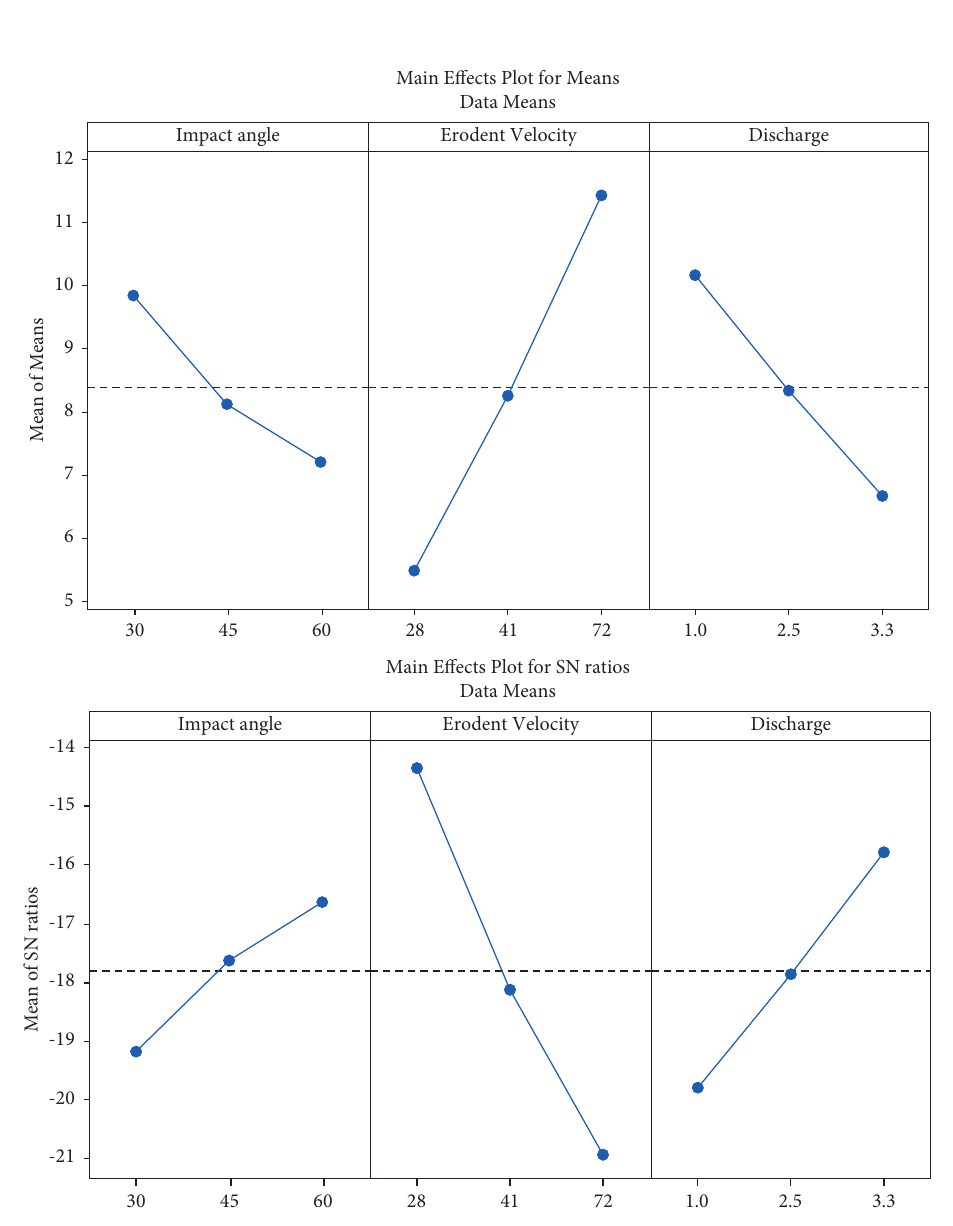
Figure 7: Main effect plots for means and SN